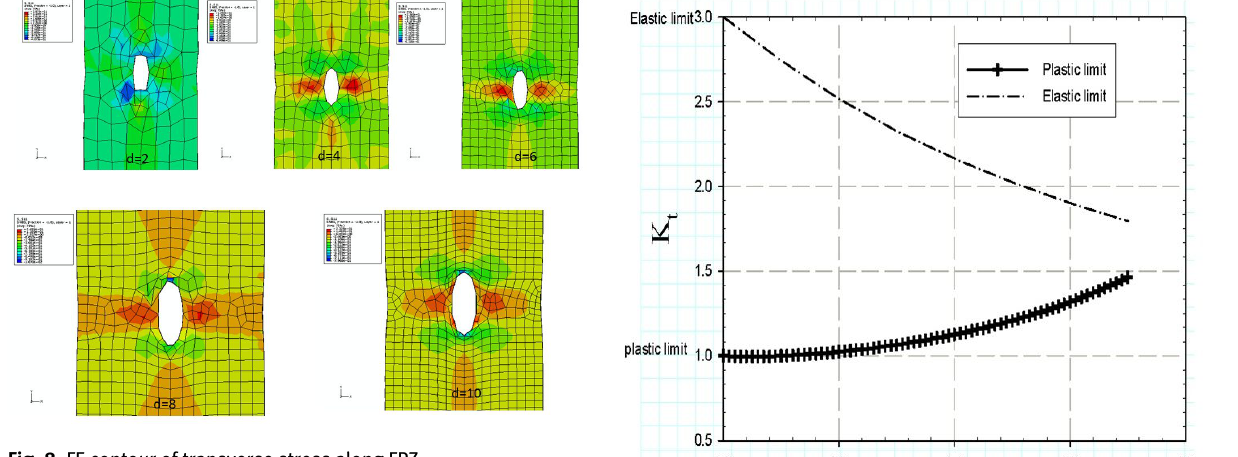
Fig. 8. FE contour of transverse stress along FPZ.